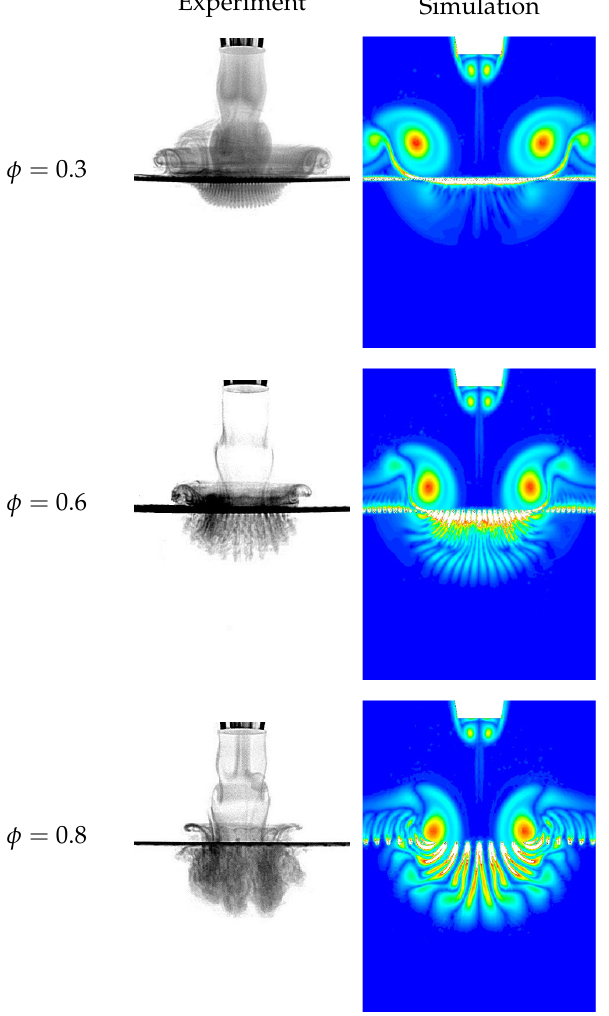
Figure 9. Comparison of air vortex ring structure after hitting the screen, current simulation vs. experimental results from An et al. [14]: Re = 1800, t = 0.66